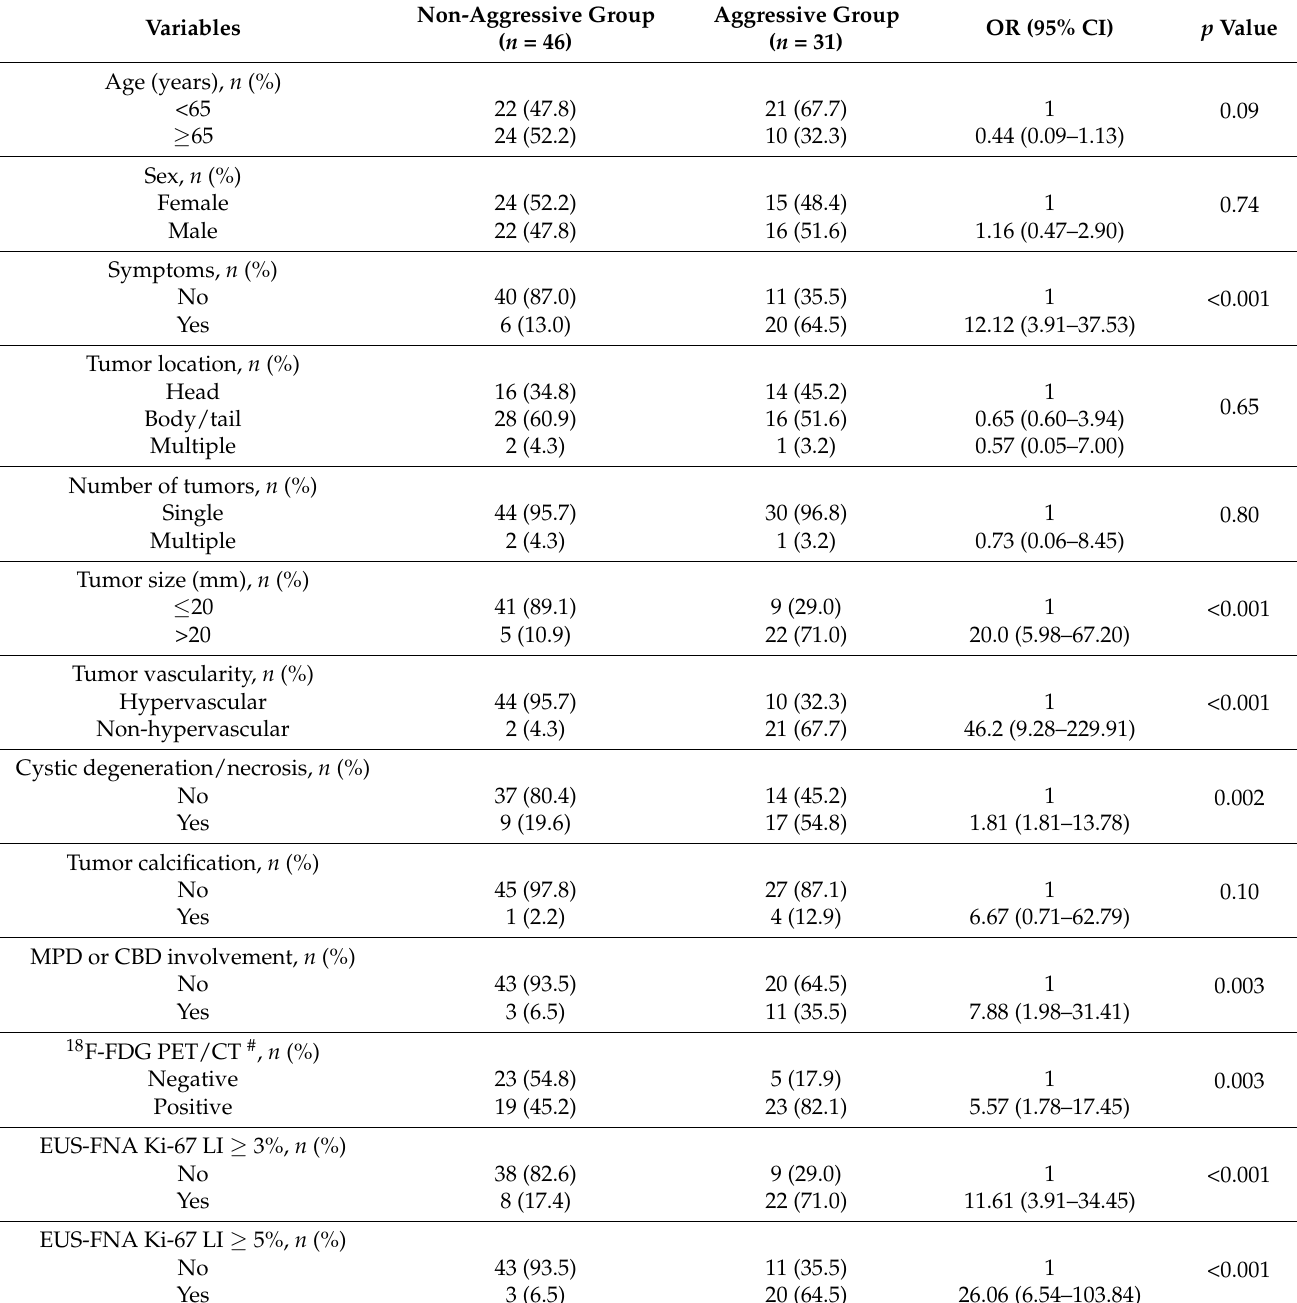
Table 3. Univariate analysis of candidate